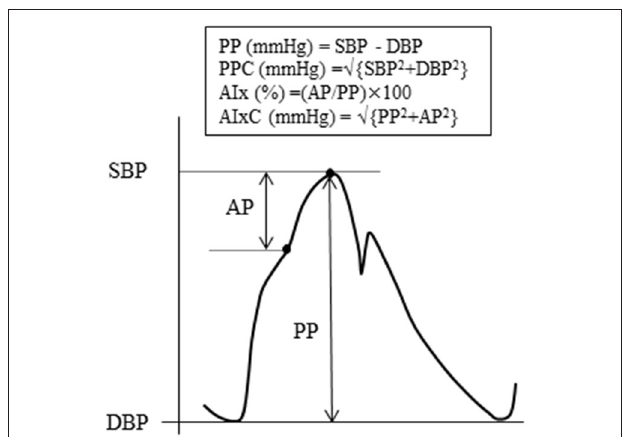
FIGURE 2 | Schema of aortic pulse wave analysis. The augmentation index (AIx) is defined as the ratio of augmentation pressure (AP, from the inflection point of systolic shoulder to the systolic peak) to pulse pressure (PP, the difference between systolic and diastolic blood pressure). The companion of PP (PPC) is the square root of the sum of the squared systolic and diastolic pressures, respectively. The companion of AIx (AIxC) is the square root of the sum of the squared PP and the squared